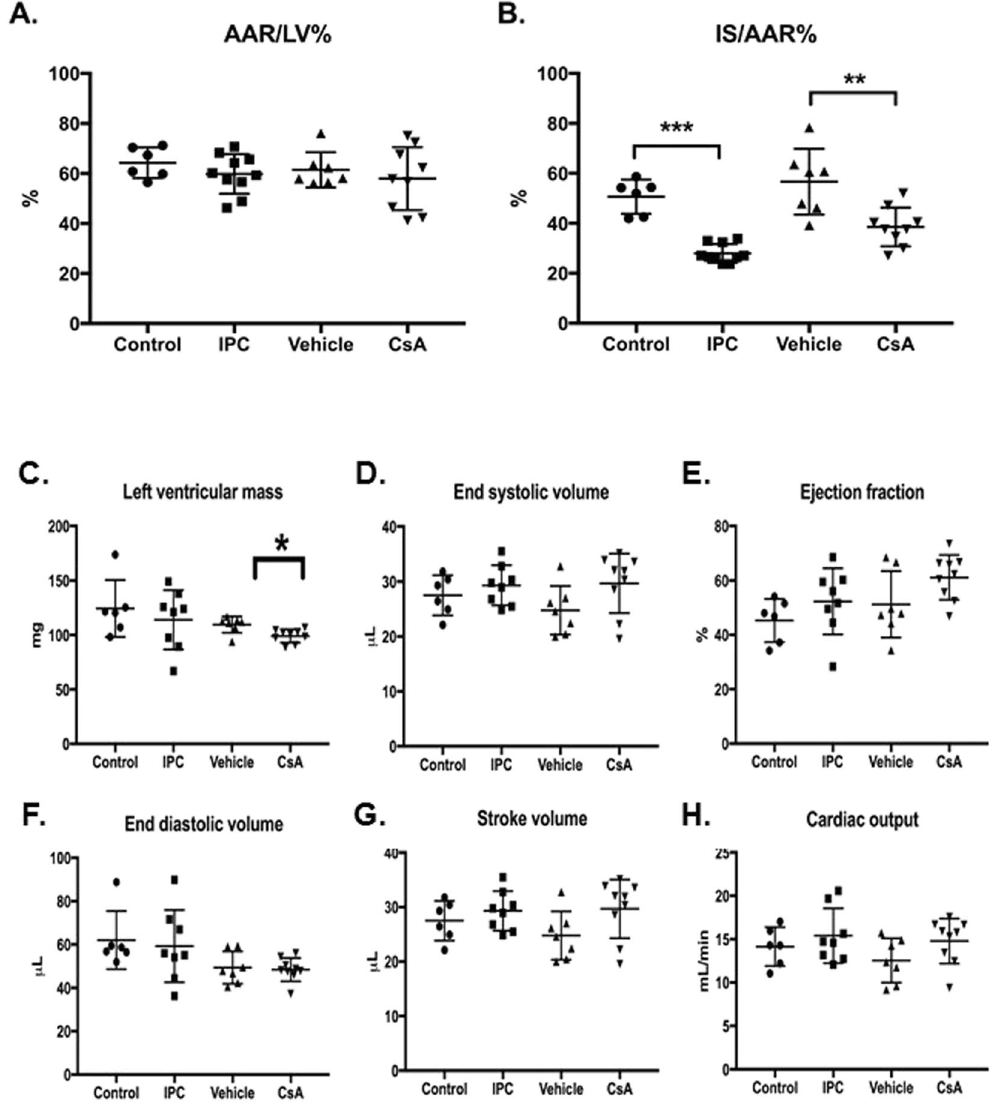
Figure 1. Effect of cardioprotective treatments on area-at-risk, myocardial infarct size in mouse AMI model. ( A ) Myocardial AAR as a fraction of left ventricle area (AAR/LV%) determined by ex vivo histological staining. AAR/LV%: control 64.3 ± 6.1, n = 6; IPC 59.8 ± 7.9, n = 10; vehicle 65.4 ± 7.0, n = 8; CsA 58.0 ± 12.6, n = 9; data are mean ± SD; one-way ANOVA p = 0.18. ( B ) Infarct size as a fraction of AAR (IS/AAR%) determined by ex vivo histological staining. IPC study: IS/AAR%: control 50.6 ± 6.9, n = 6; IPC 27.9 ± 3.7, n = 10; unpaired t-test *** p < 0.001. CsA study: vehicle 56.6 ± 13.6, n = 7; CsA 38.6 ± 7.8, n = 9; data are mean ± SD; unpaired